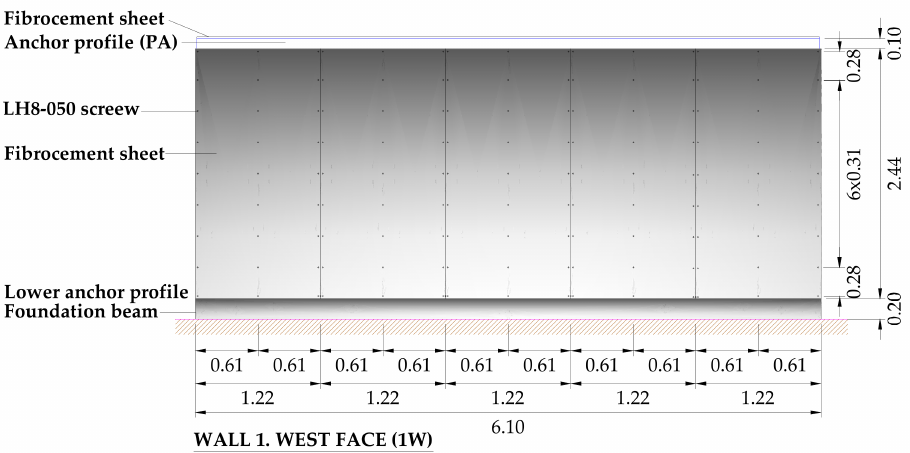
Figure 3. Wall 1 of the experimental specimen at full-scale (west face).